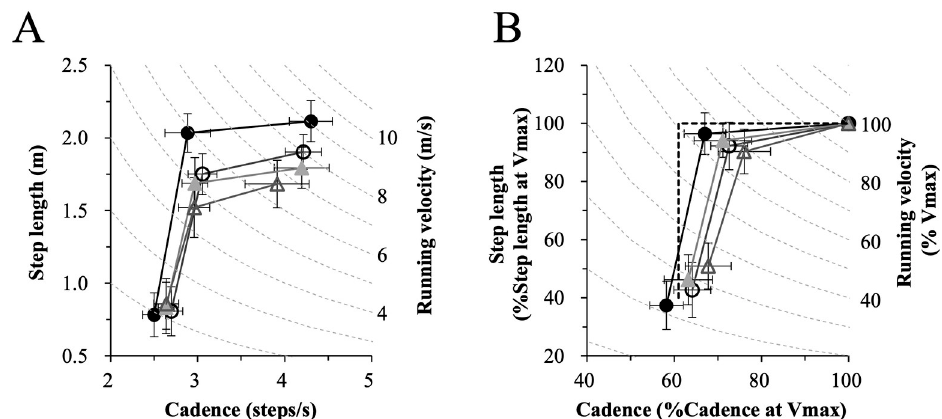
Fig 3. Mean values of cadence and step length at the maximal running velocity (Vmax), inflection point (IP), and minimal running velocity (Vmin) (A), and those with cadence and step length normalized to those under Vmax (B) for each subject group. The error bars depict the standard deviation. The filled circles, open circles, filled triangles, and open triangles represent sprinters, distance runners, active athletes and sedentary individuals, respectively. Pale broken lines represent running velocity (A) and running velocity normalized by maximal running velocity (B). The thick broken line in B illustrates the limiting situation, in which velocity change is only done with a step length change in the velocity range below the inflection point, and only with a cadence change above the inflection point.